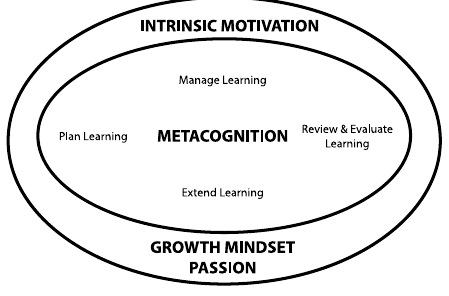
Figure 2: Fundamentals will be covered in semester 1 term 1, "peer